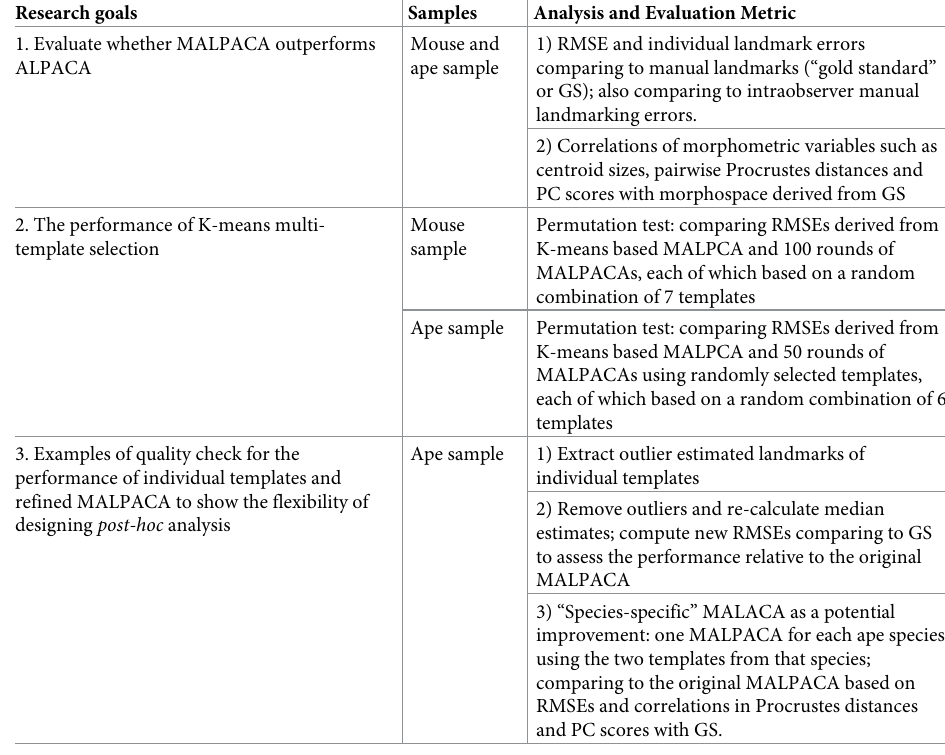
Table 1. A summary of research goals and